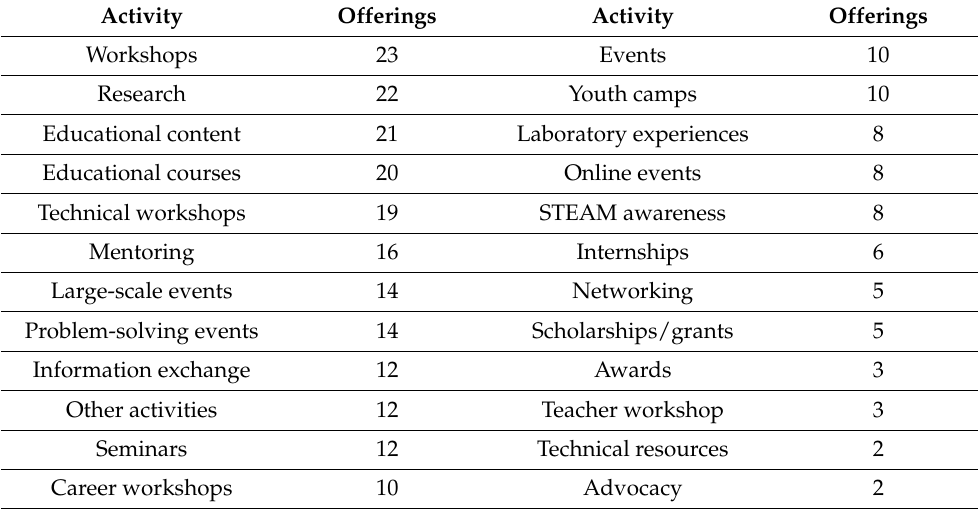
Table 2. Activity offering data. The first column indicates the activity—tagged by researchers according to data on the initiatives’ sites—and the second column indicates the number of initiatives offering that activity. Since many initiatives offer multiple activities, the total activities offered will exceed the number of